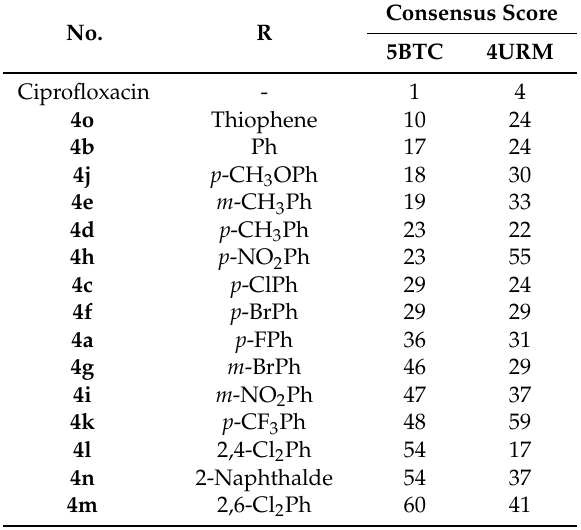
Table 4. Molecular modeling consensus score for the tested compounds and Ciprofloxacin.